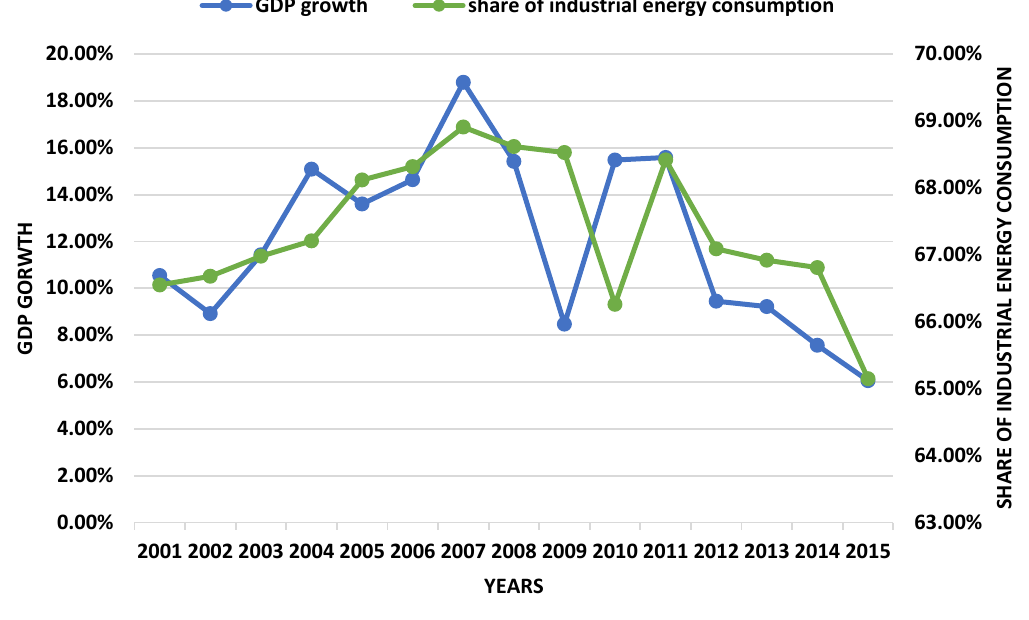
Figure 7. Share of Industrial Energy Consumption vs. GDP Growth.